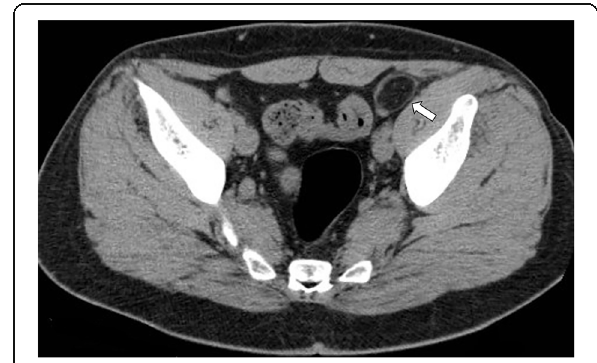
Fig. 3 Acute epiploic appendagitis in a 43-year-old man with presumptive clinical diagnosis of colonic diverticulitis. Axial non- contrast CT image shows a pericolonic fat-density lesion (arrow) that abuts anteriorly the colon-sigmoid junction in the left iliac fossa